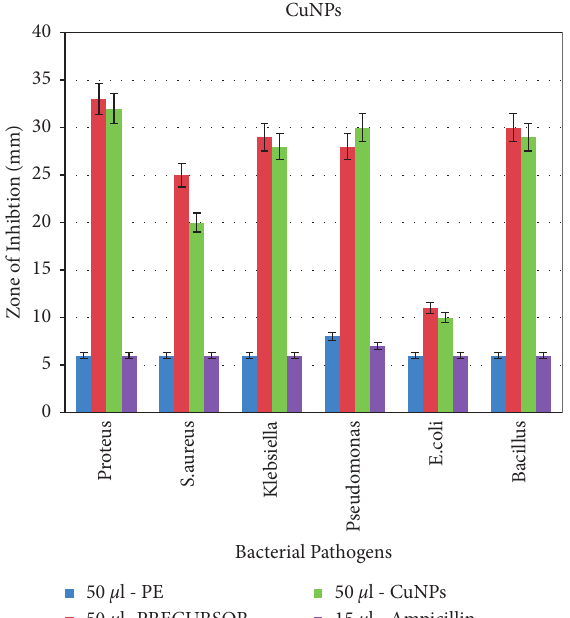
Figure 8: Graphical representation of the antibacterial activity of copper nanoparticles. Y -axis: zone of inhibition in mm, and X -axis: bacterial pathogens.